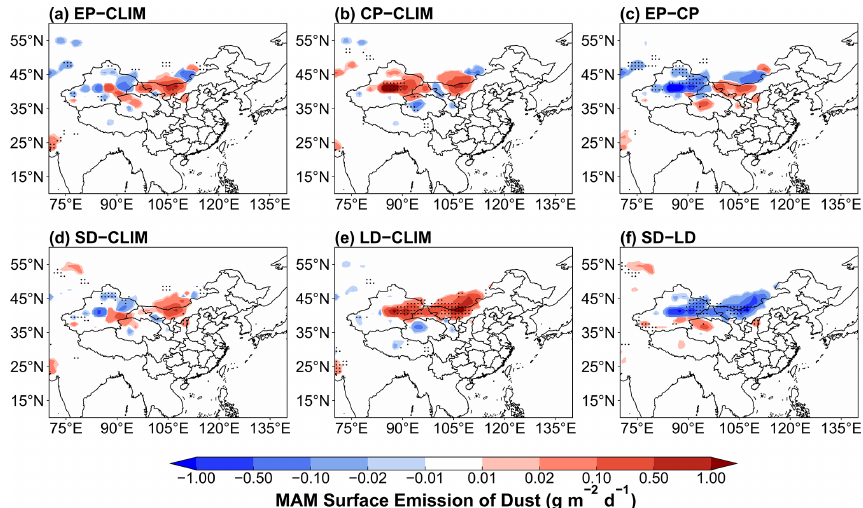
Figure 9. Composite differences in MAM mean dust emissions (gm − 2 d − 1 ) between EP and CLIM in (a) , CP and CLIM in (b) , EP and CP in (c) , SD and CLIM in (d) , LD and CLIM in (e) , and SD and LD in (f) . The stippled areas indicate statistical significance with 90% confidence from a two-tailed t